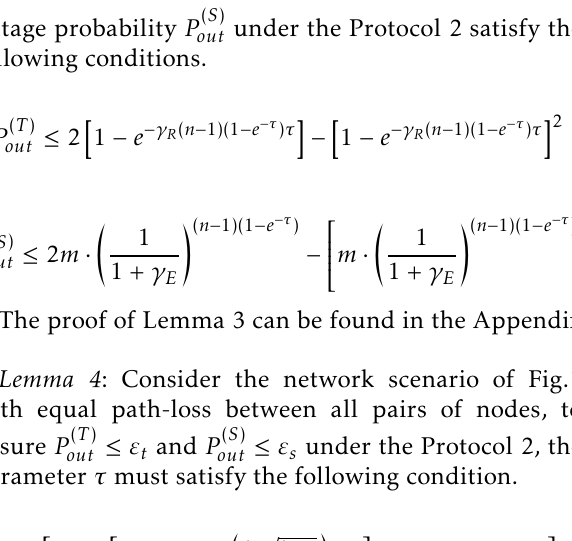
Figure 2. Coordinate system for the scenario where path-loss between pairs of nodes is based on their relative